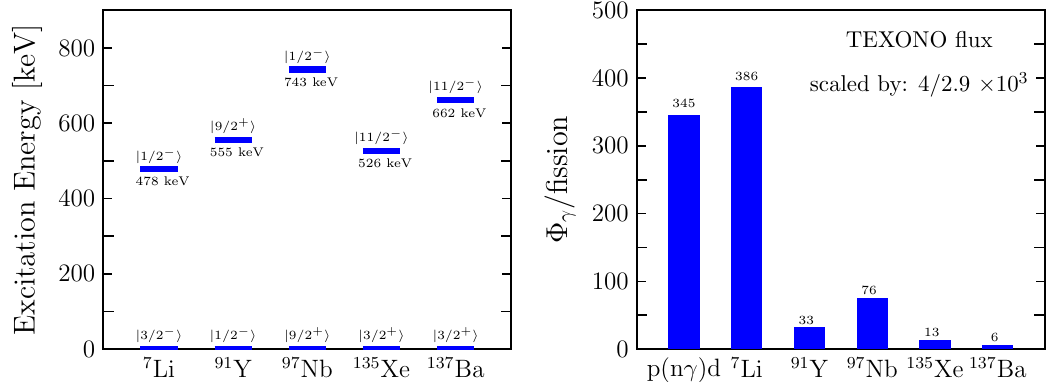
Figure 5 . Left graph : E = 478 keV M 1 transition from the excited state to the ground state of 7 Li along with M 4 transitions from the excited to the ground state of 91 Y, 97 Nb, 135 Xe and 137 Ba (see text for more details). These transitions involve γ/a lines at 555 keV, 743 keV, 526 keV and 662 keV, respectively. Right graph : photon flux for a 4 GW power plant and for each of the channels considered in our analysis. They follow from the TEXONO flux rescaled by 4/2.9 [34].